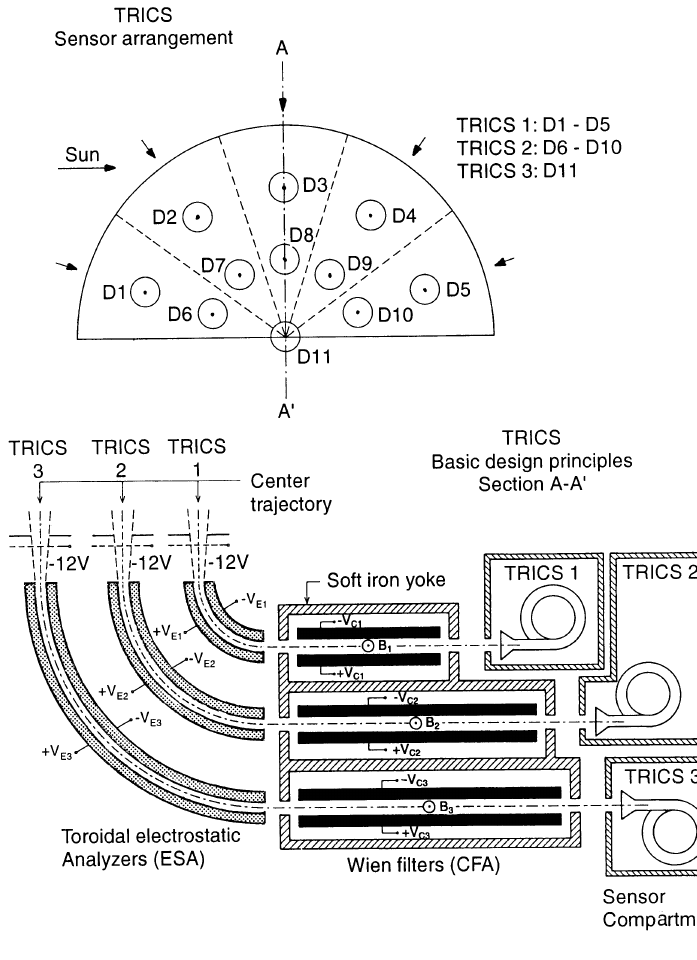
Fig. 4. Basic design principles of